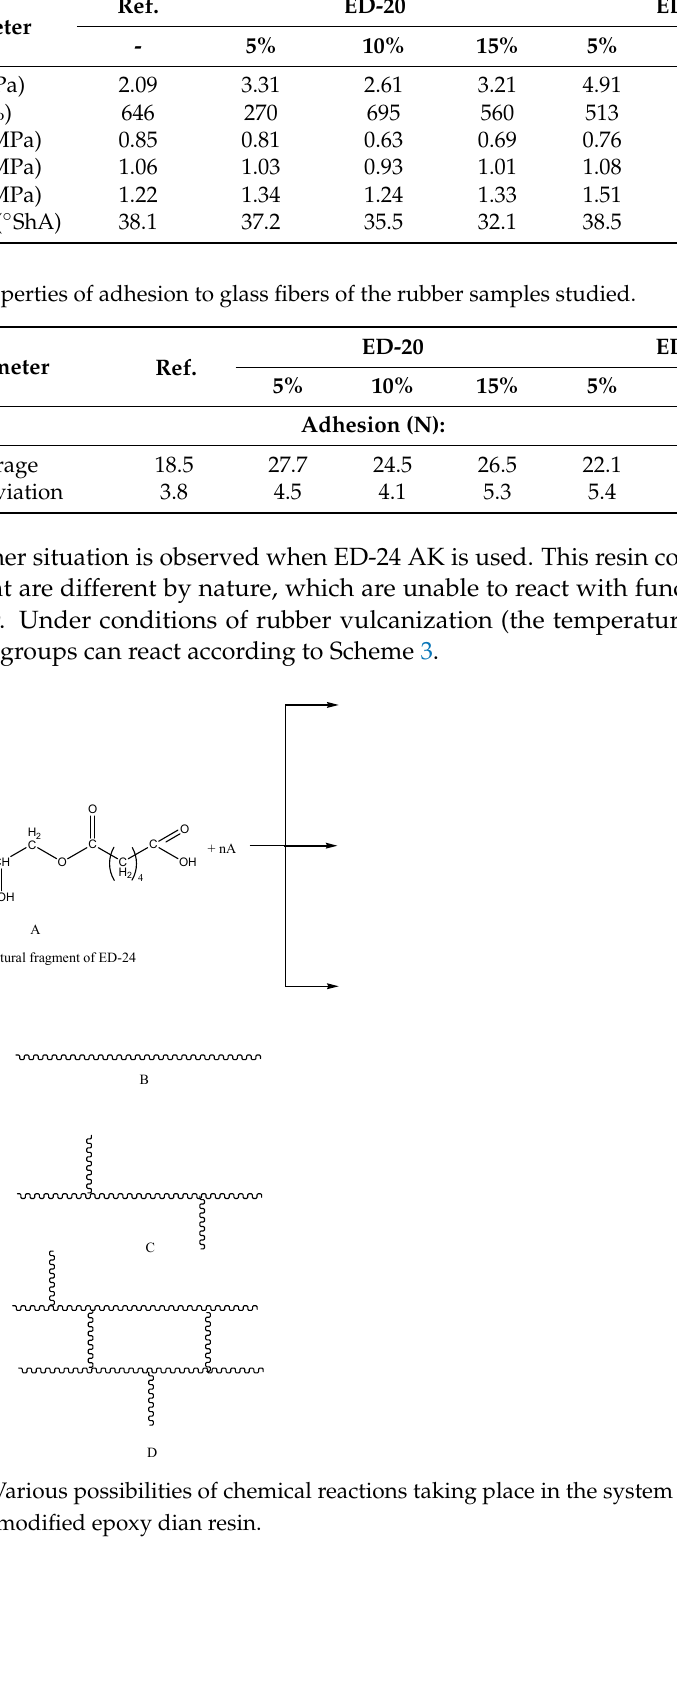
Table 3. Mechanical characterization of the rubber samples studied. Ref. Parameter